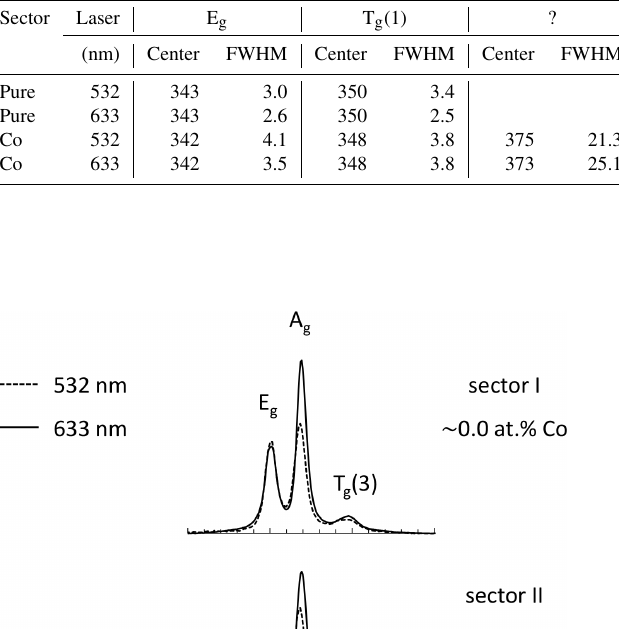
Table 4. Frequencies and FWHM of observed Raman modes of pyrite measured on cut surface (cm − 1 ). Sector